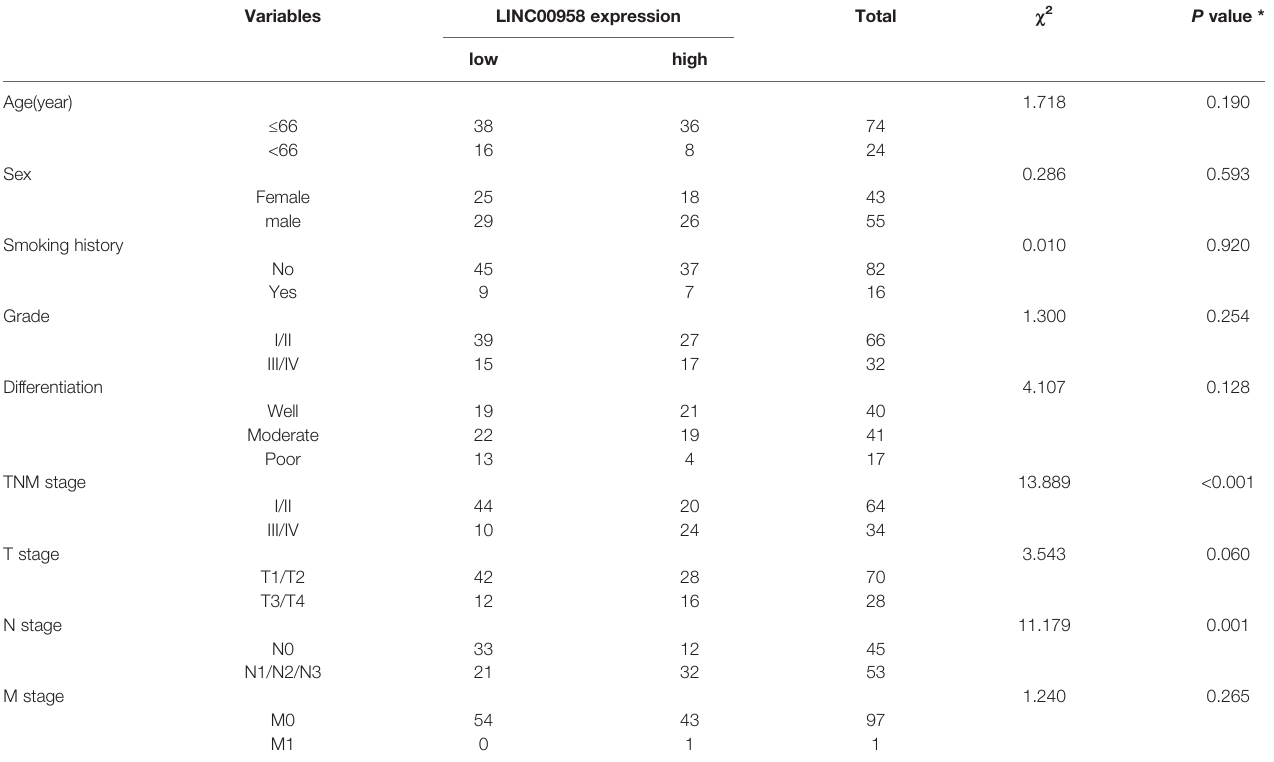
TABLE 1 | Correlation between LINC00958 expression and clinicopathological characteristics of LUAD patients.